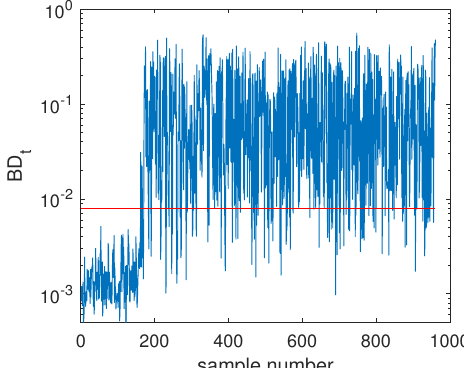
Figure 10. Fault detection chart of fault F19 based on